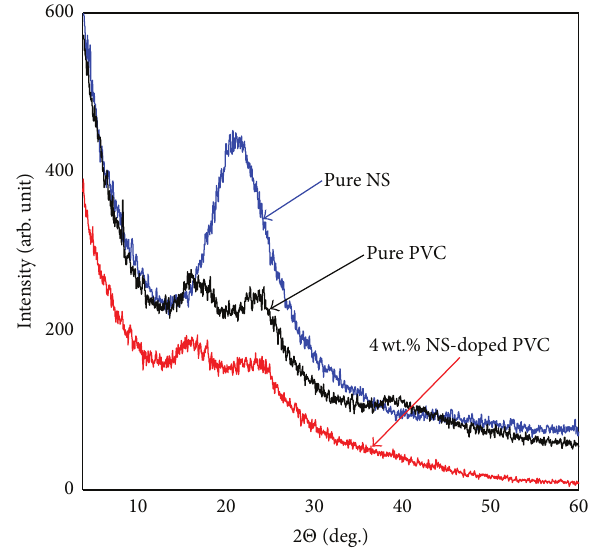
Figure 1: X-ray diffraction pattern for pure PVC, pure SiO 2 nano- particles, and 4wt% SiO 2 -doped